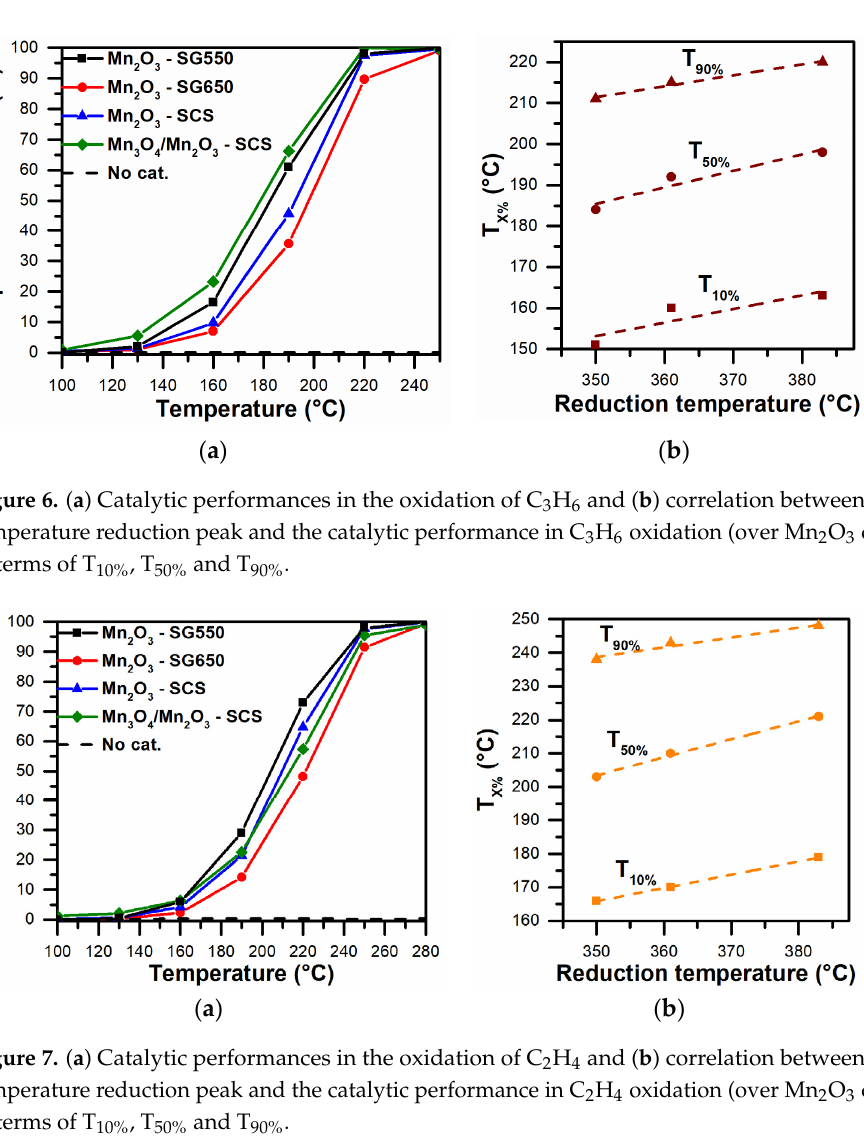
Figure 7. ( a ) Catalytic performances in the oxidation of C 2 H 4 and ( b ) correlation between the low- temperature reduction peak and the catalytic performance in C 2 H 4 oxidation (over Mn 2 O 3 cata- lysts) in terms of T 10% , T 50% and T 90% .